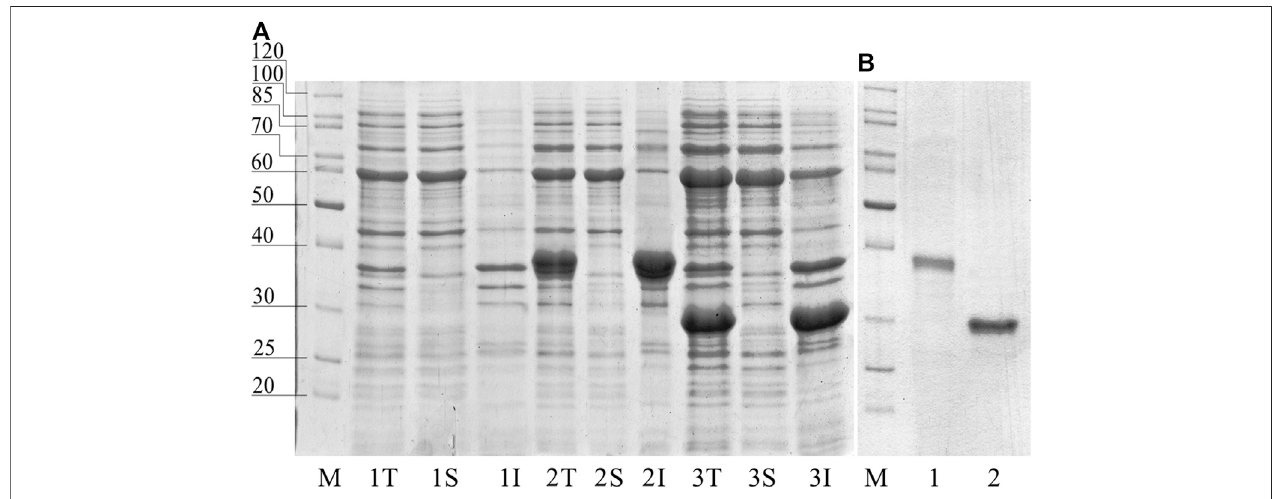
FIGURE 2 | (A) SDS-PAGE of total (T), insoluble (I) and soluble (S) fraction of E. coli Arctic express (DE3). (1) non-induced control, (2) E. coli Arctic express (DE3) expressing Chit19; (3) E. coli Arctic express (DE3) expressing Chit19 Δ ChBD (3). (B) Refolded and puri fi ed Chit 19 (1) and Chit19 Δ ChBD